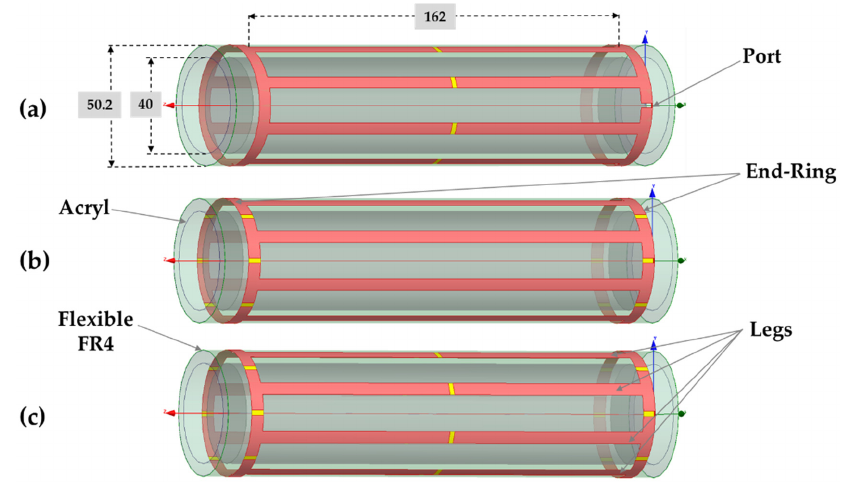
Figure 7. Configurations of the birdcage RF coil for the reception of 1 H NMR signal at 1.5 T and 3 T MRI systems: ( a ) Low pass; ( b ) high pass; ( c ) band pass. (All dimensions are in